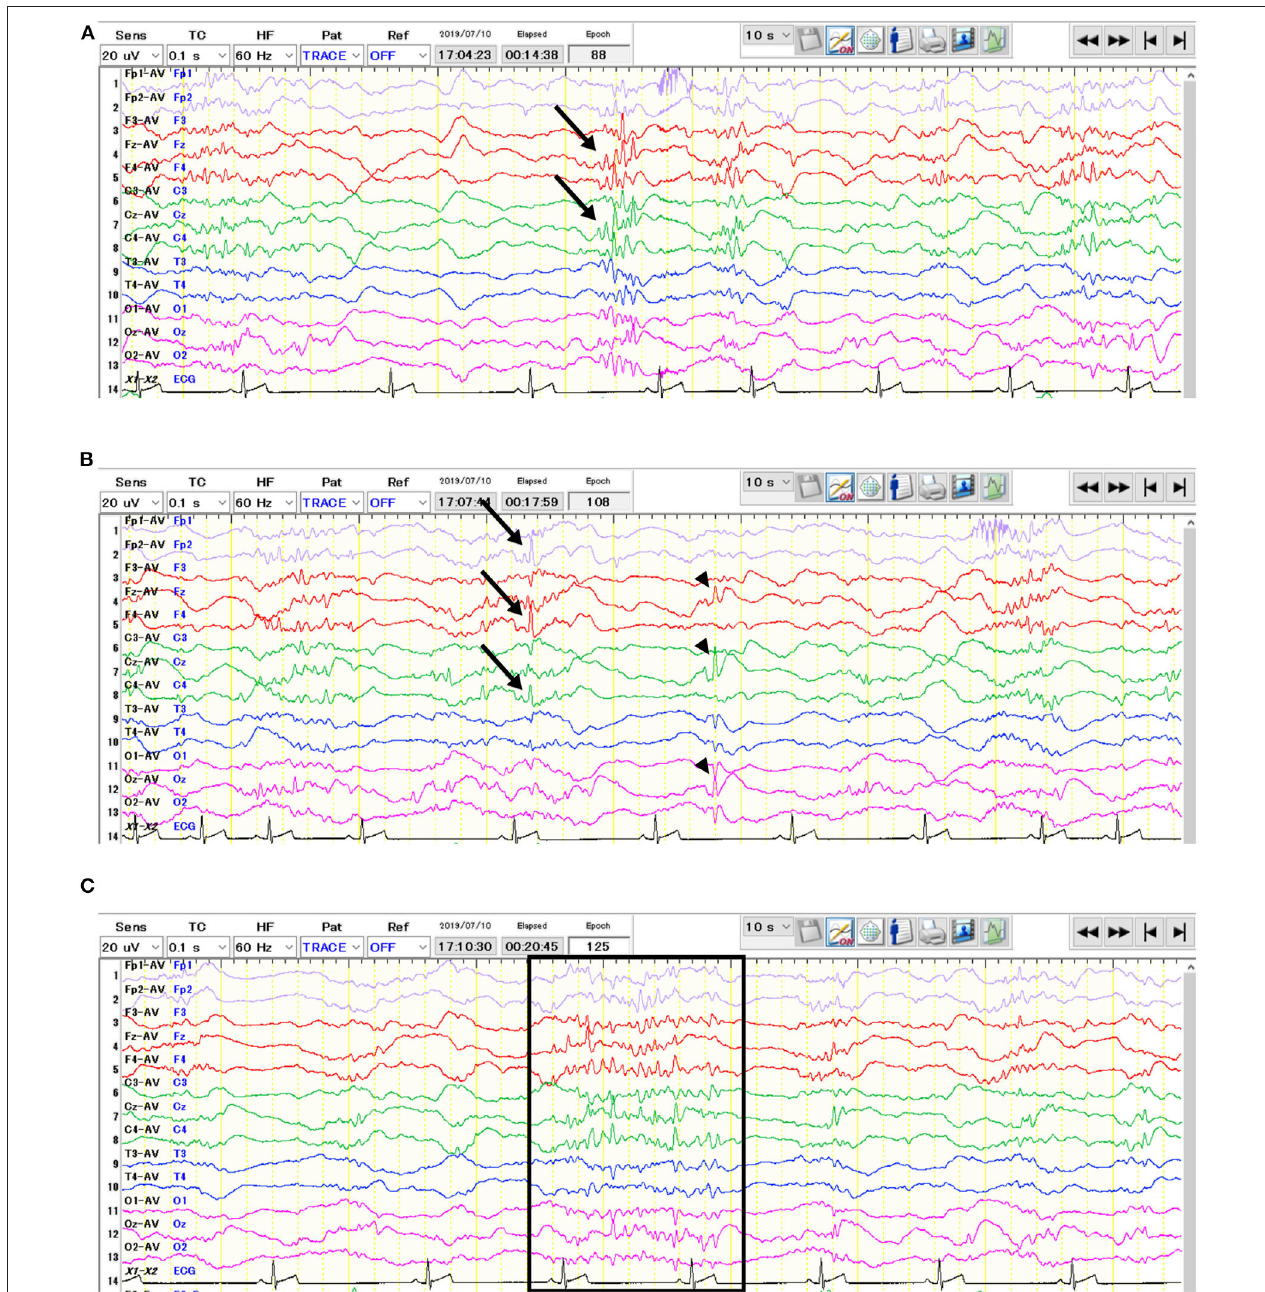
FIGURE 1 | Interictal electroencephalogram of the 64-days-old puppy with neonatal encephalopathy with seizures. The average potential reference method was used. Polyspikes ( A , arrows) and isolated spikes ( B , arrows & arrowheads) were observed. In addition, alpha-band rhythms consisted of spikes and sharp waves ( C , surrounded by the rectangle) were also